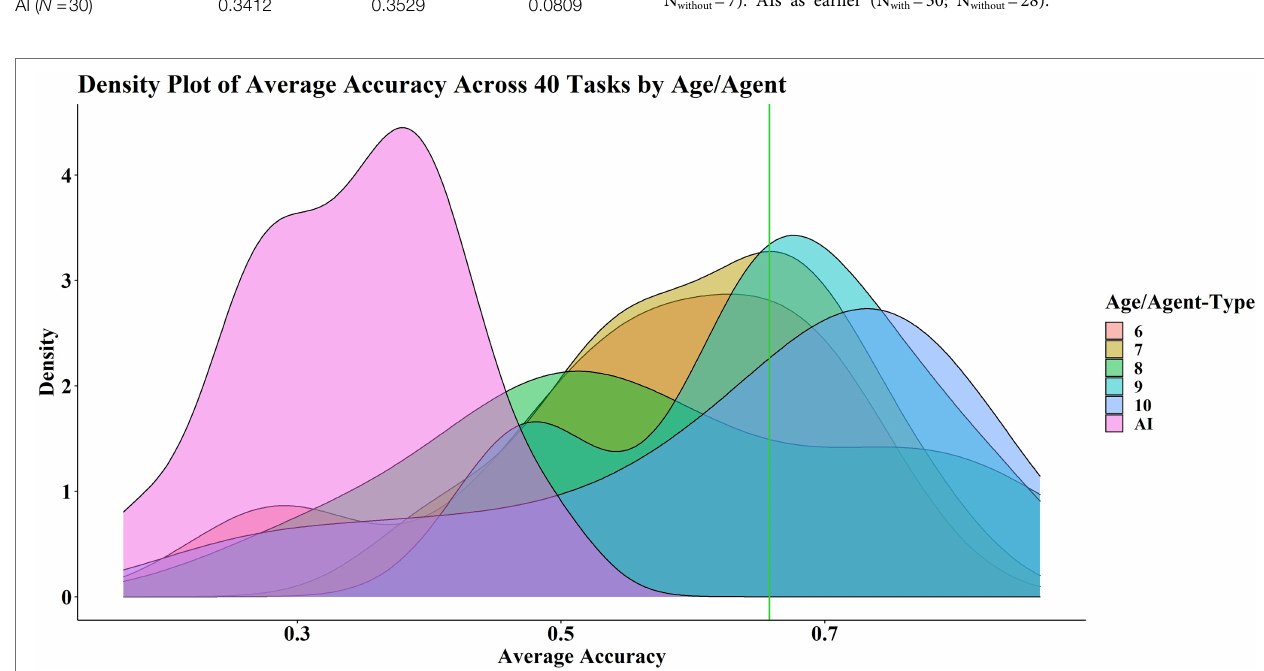
FIGURE 4 | Density of plot of average score across 40 tasks, by age/agent type. The green line shows the average pass mark across 40